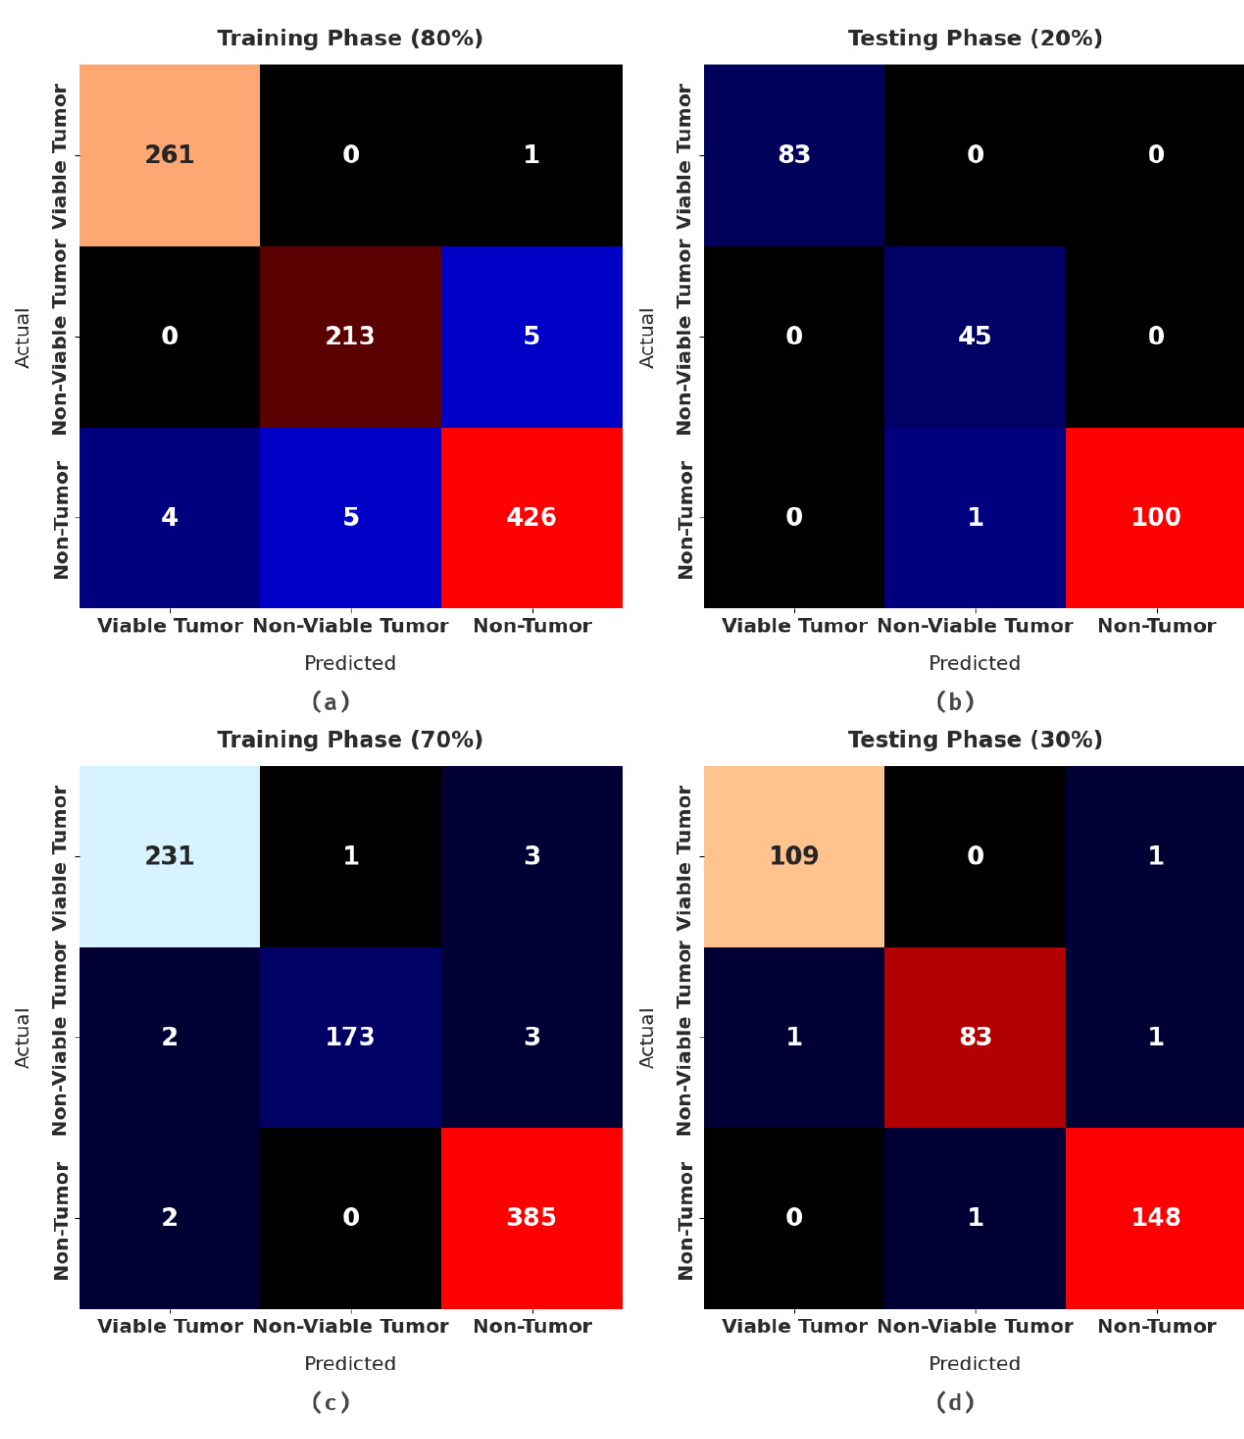
Figure 4. Confusion matrices of WDODTL-ODC technique ( a ) 80% of TR data, ( b ) 20% of TS data, ( c ) 70% of TR data, and ( d ) 30% TS data. ( c ) 70% of TR data, and ( d ) 30% TS